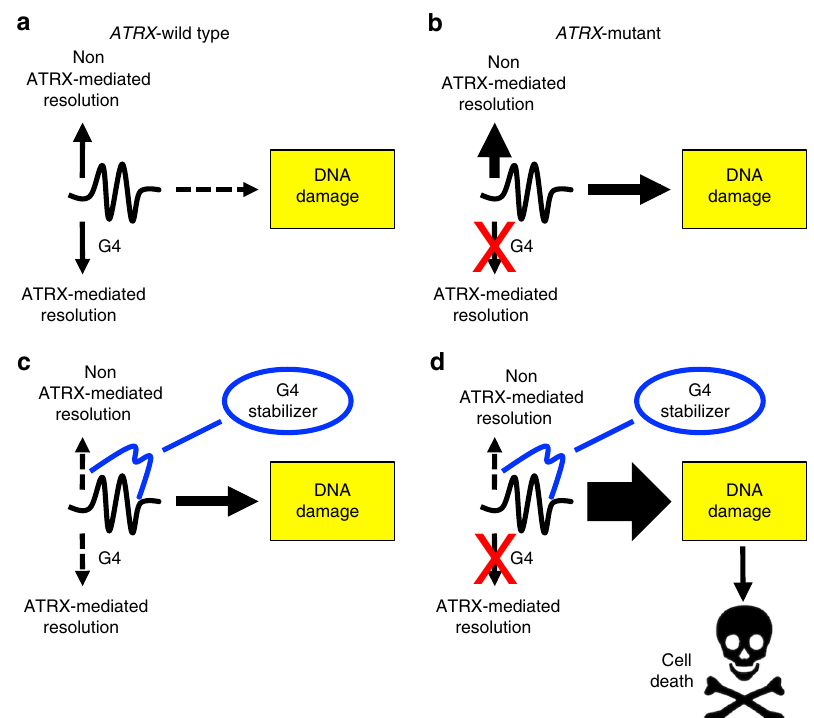
Fig. 9 Selectively targeting G4s in the ATRX-de fi cient context. G4s are normally resolved by both ATRX-dependent and ATRX-independent mechanisms to mitigate DNA damage in cells ( a ). In the setting of ATRX de fi ciency, DNA damage increases but its cytotoxic effects are dampened by ATRX-independent G4 resolution, maintaining cellular viability ( b ). However, concurrent G4 stabilization impairs these salvage pathways ( c , d ) further enhancing DNA damage and inducing cell death in the ATRX-de fi cient